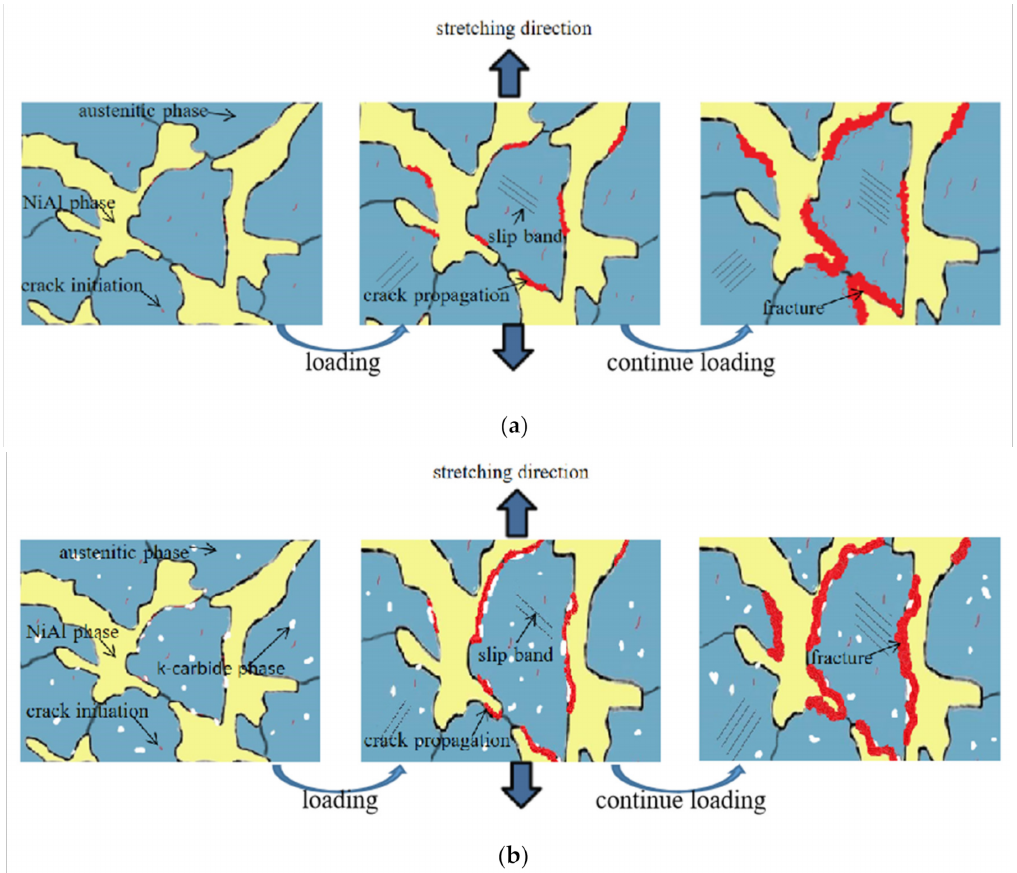
Figure 14. Dynamic crack propagation mechanism of Fe-25Mn- x Al-8Ni-C alloy, ( a ) 10 wt.% Al; ( b ) 13 wt.%